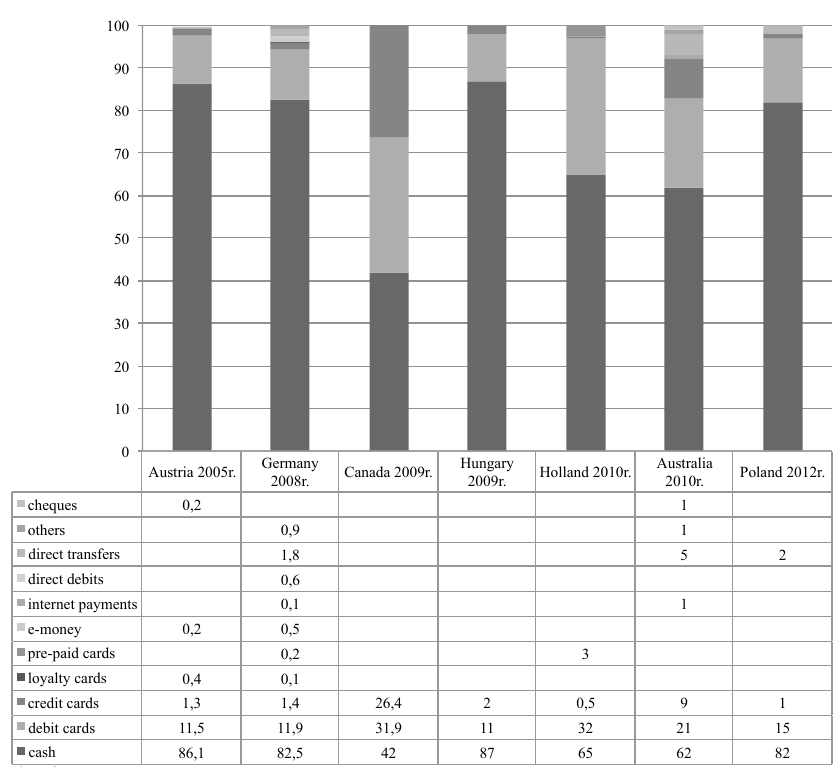
Fig. 4. Payment instruments structure in selected countries But during the last decade, card payments in particular have led to a shift from cash to cashless payments (see figure 5). Ongoing innovations in retail payments have tended to a further reduction of the cash market share. However, as cash is used mainly for small-value transactions, especially in proximity and P2P payments, substantial substitutive effects can only be expected for the innovations that target these areas. According to 72% Polish customers, innovative payment methods are a competition for cash payments. Among them 42% stated that they are competitive for all kind of cash payments. For 30% of responders they are competitive only for micropayments. 19% of them declare that they are ready to start using innovative instruments against cash immediately, 34% - under some conditions (especially safety improvement) and 29% - in the nearest future. 22% of responders are not interested in using innovative payment methods